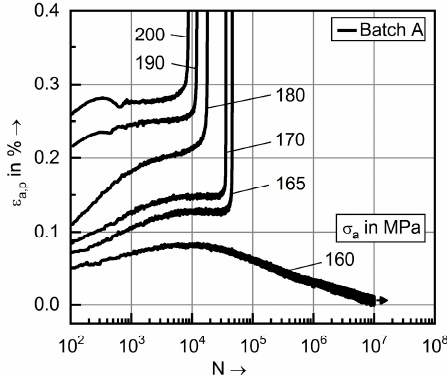
Figure 9. Development of plastic strain amplitude ε a,p versus load cycles N in HCF tests at T = 300 °C with f = 20 Hz.